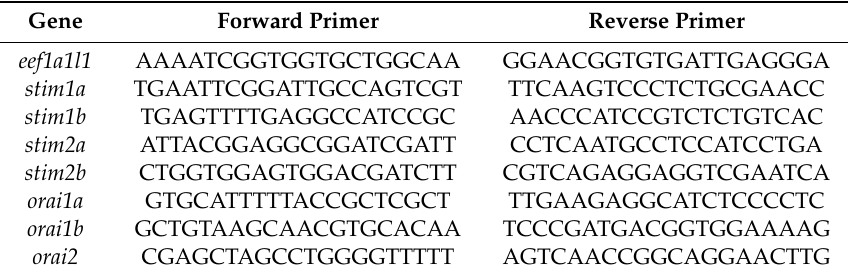
Table 2. Primers that were used for Real-Time Polymerase Chain Reaction. Gene Forward